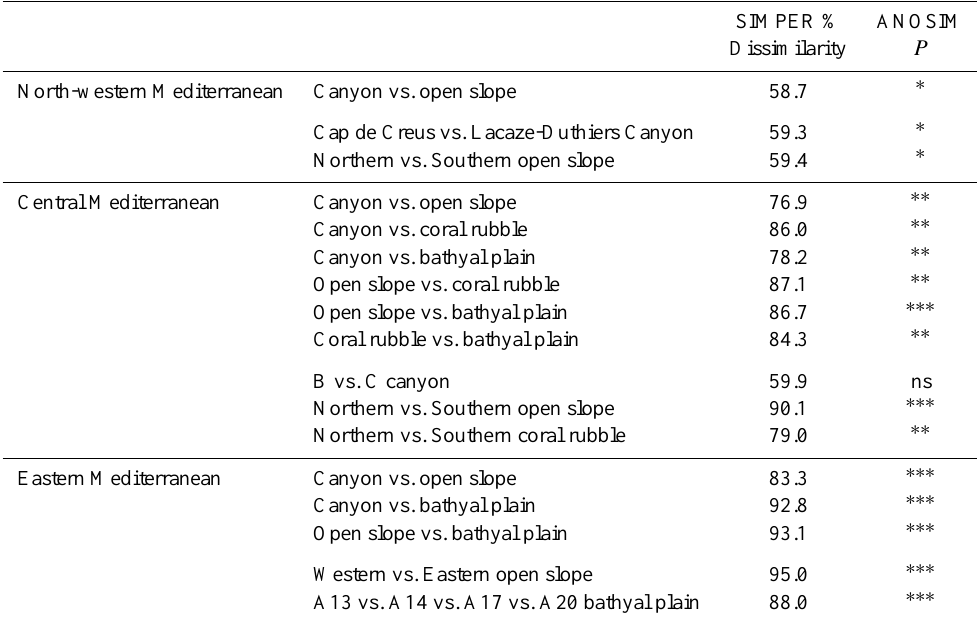
Table 4. Results of SIMPER and ANOSIM analyses for the dissimilarities in the nematode species compositions between the different deep-sea habitats and sampling sites in all the regions investigated in the present study.